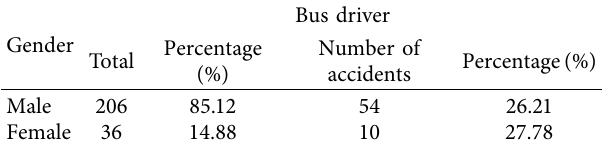
Table 3: Gender distribution.